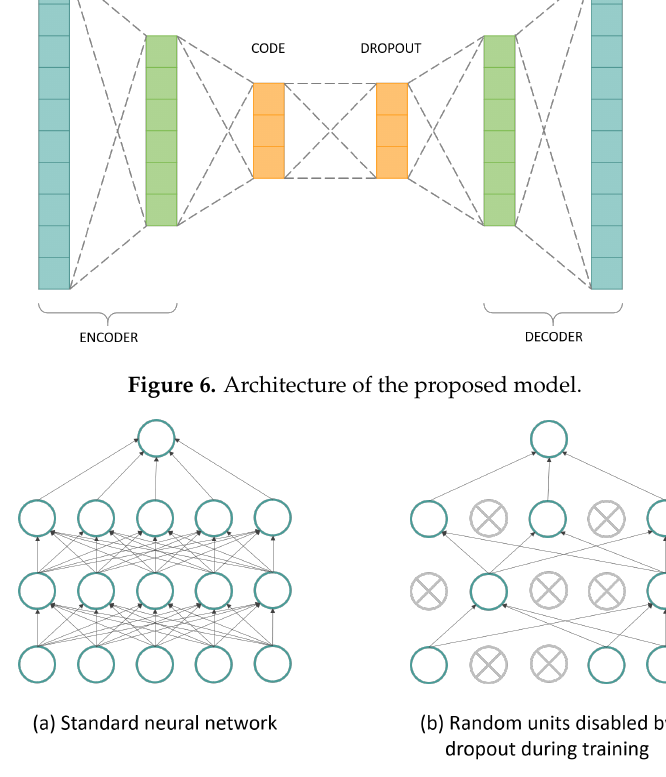
Figure 7. Dropout neural network